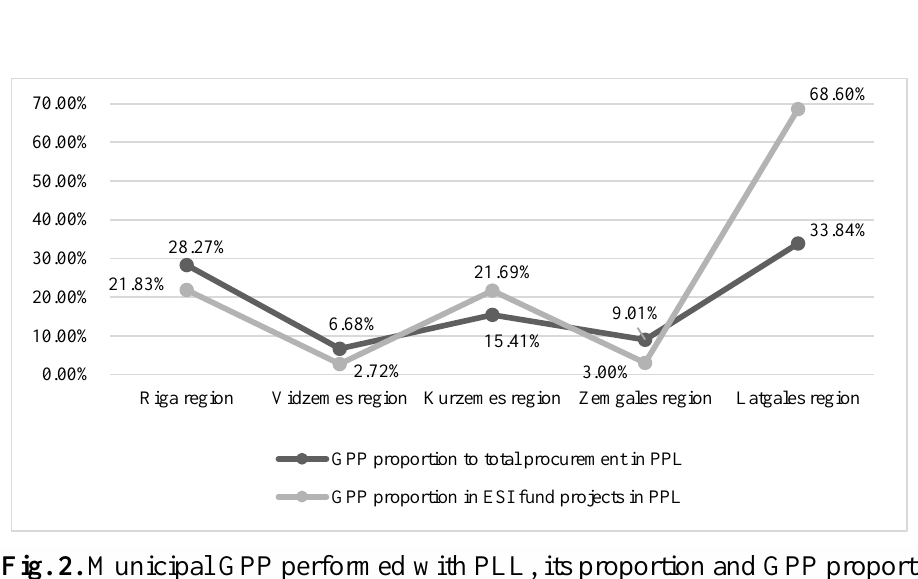
Fig. 2. Municipal GPP performed with PLL, its proportion and GPP